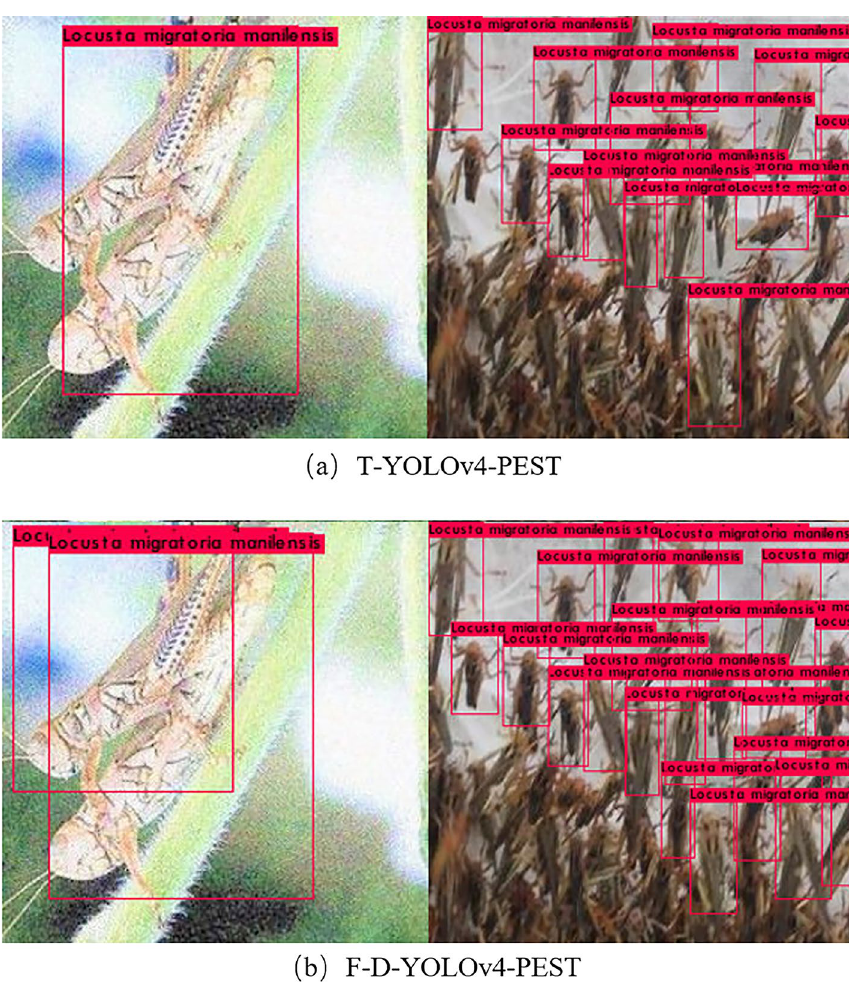
Figure 16. The actual detection results under high overlap and high density situations.